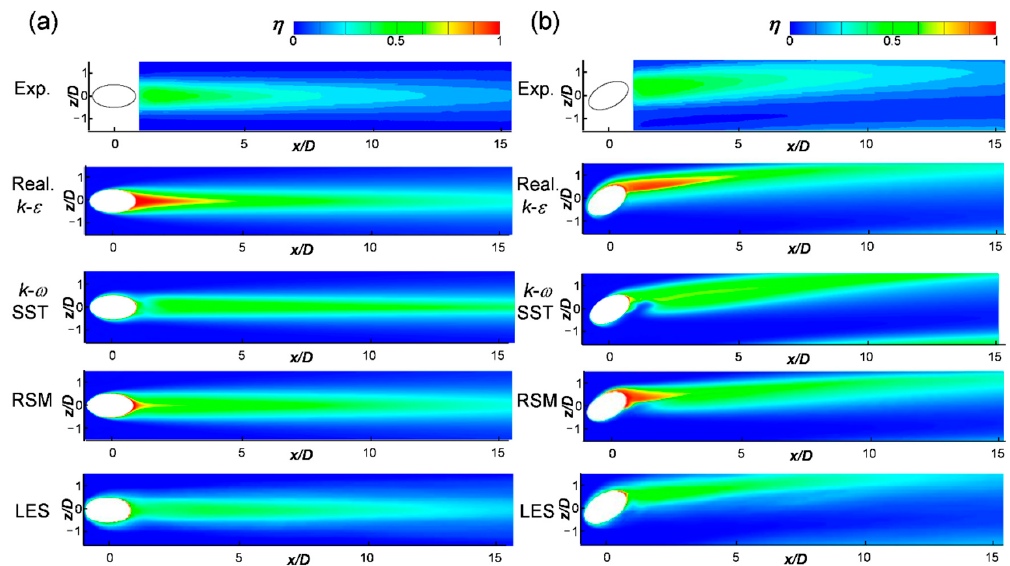
Figure 7. Local adiabatic film cooling effectiveness distributions at M = 0.5: ( a ) β = 0° and ( b ) β = 30°.